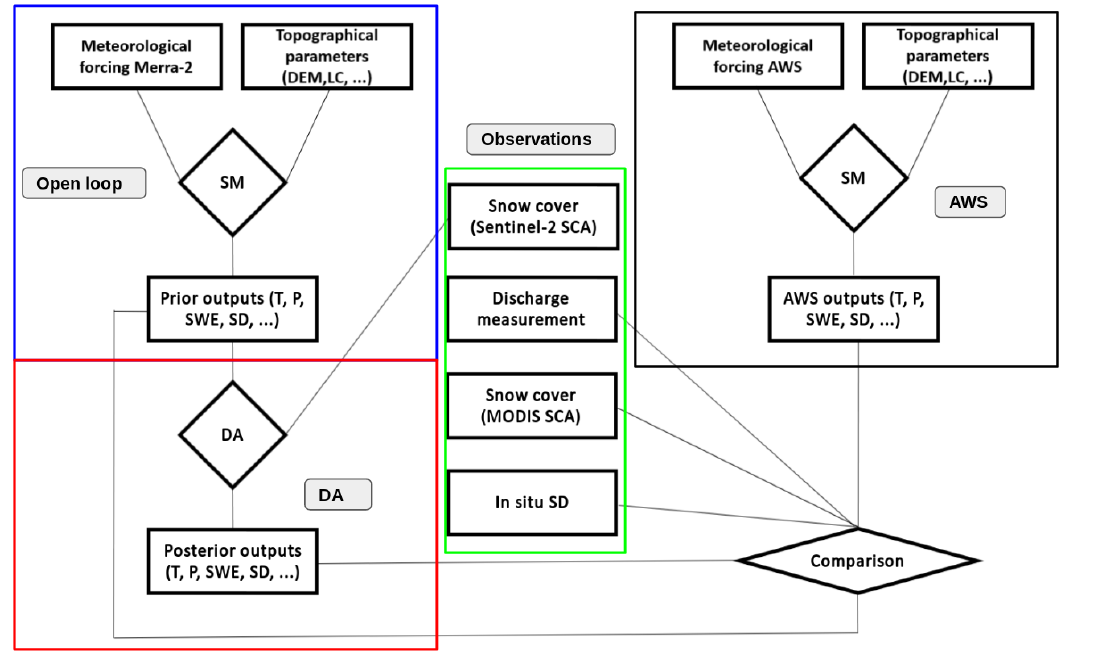
Figure 3. Simplified schematic illustrating the input and output of the DA scheme. SM refers to SnowModel. DA refers to data assimilation process and AWS refers to the simulation based on autmatic weather stations (AWS)